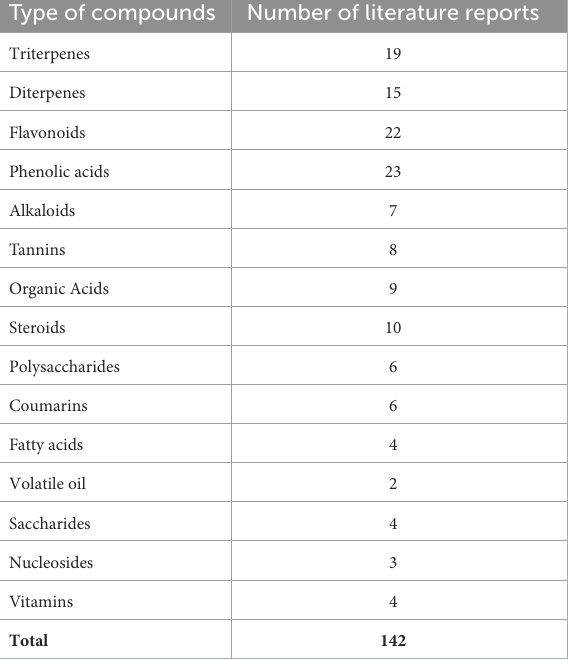
TABLE 1 Chemical components of R. Chingii Hu. Type of